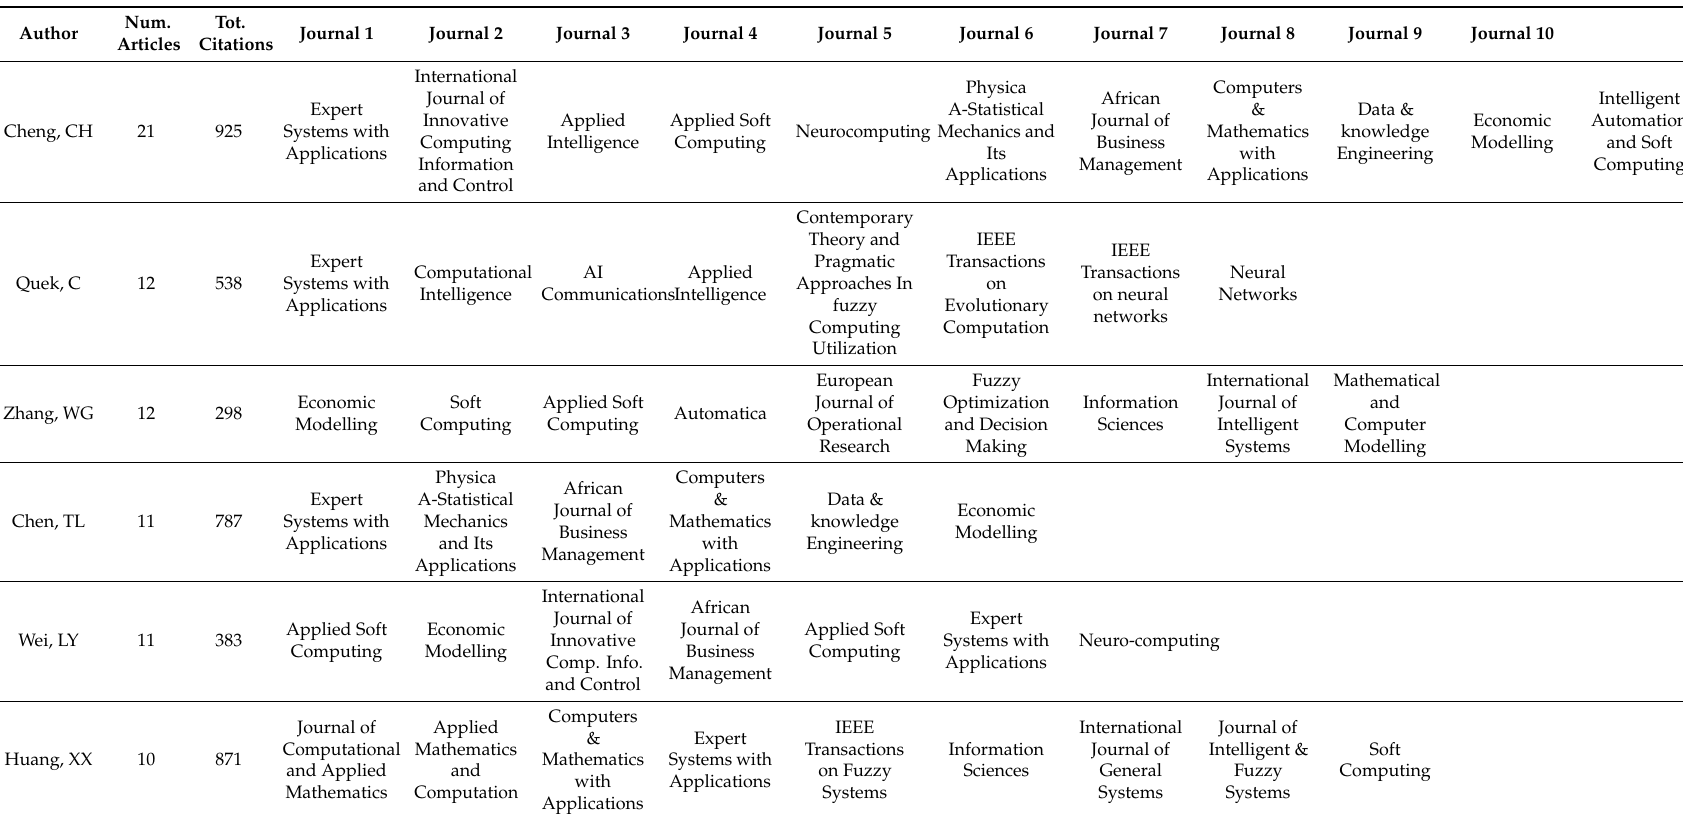
Table A1. Main authors with the largest numbers of publications in our final